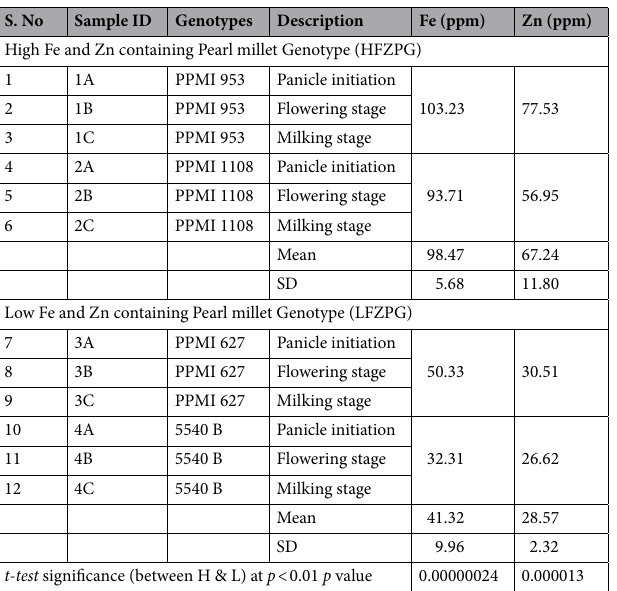
Table 1. Sample details and concentration of Iron (Fe) and Zinc (Zn) in the grains of pearl millet genotypes.